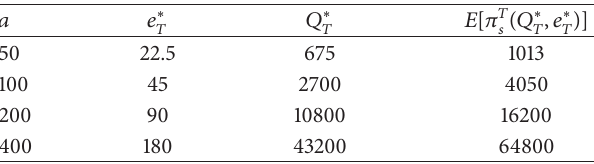
Table 5: Effect of 𝑎 on the optimal policies of the system after coordination.